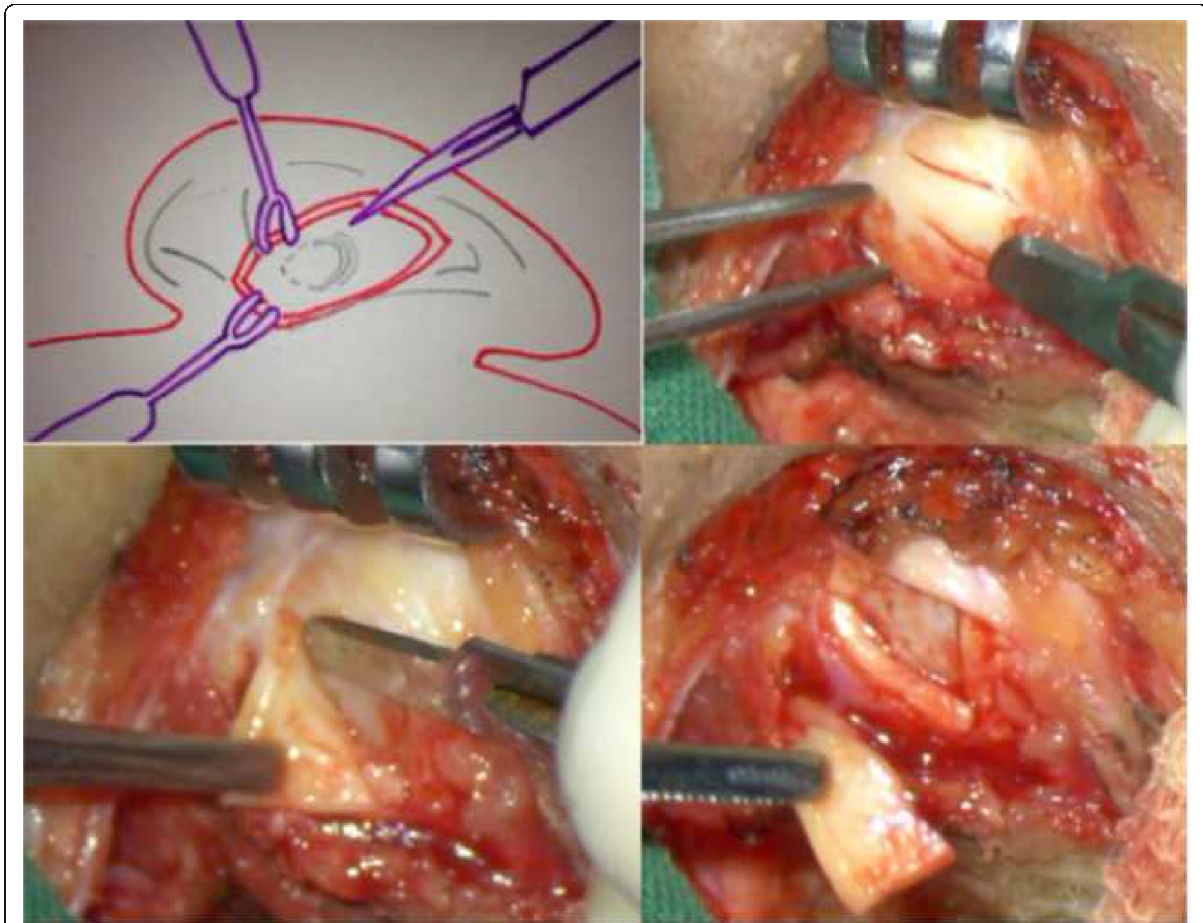
Fig. 2 Showing the method of harvesting the conchal